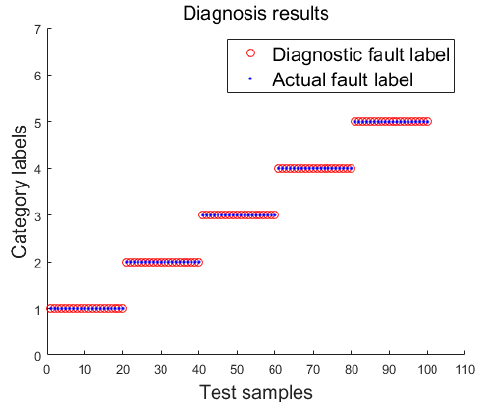
Figure 25. Classification result under condition 4.